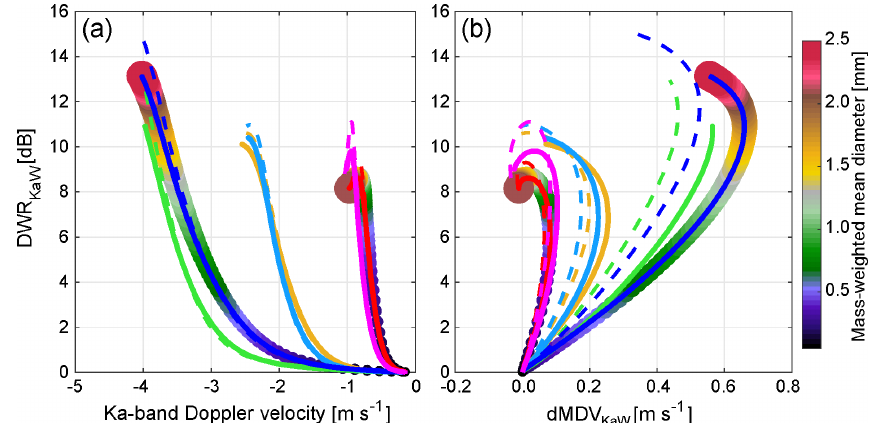
Figure 2. (a) DWR of Ka-band (35.5GHz) reflectivity to W-band (94GHz) reflectivity versus Ka-band mean Doppler velocity from the SSRGA scattering database with particle fall velocity models of Heymsfield and Westbrook (2010). (b) DWR of Ka-band reflectivity to W-band reflectivity versus difference between Ka-band MDV and W-band MDV. Negative Doppler velocity in (a) represents a downward motion. Color scale and line legends are the same as in Fig. 1. These particle models can be classified into particles of a low (red and magenta), middle (yellow and cyan), and high (blue and green) rime